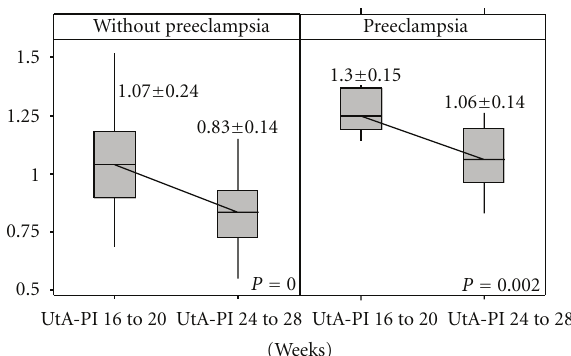
Figure 2: Variation of flow-mediated dilation in the two